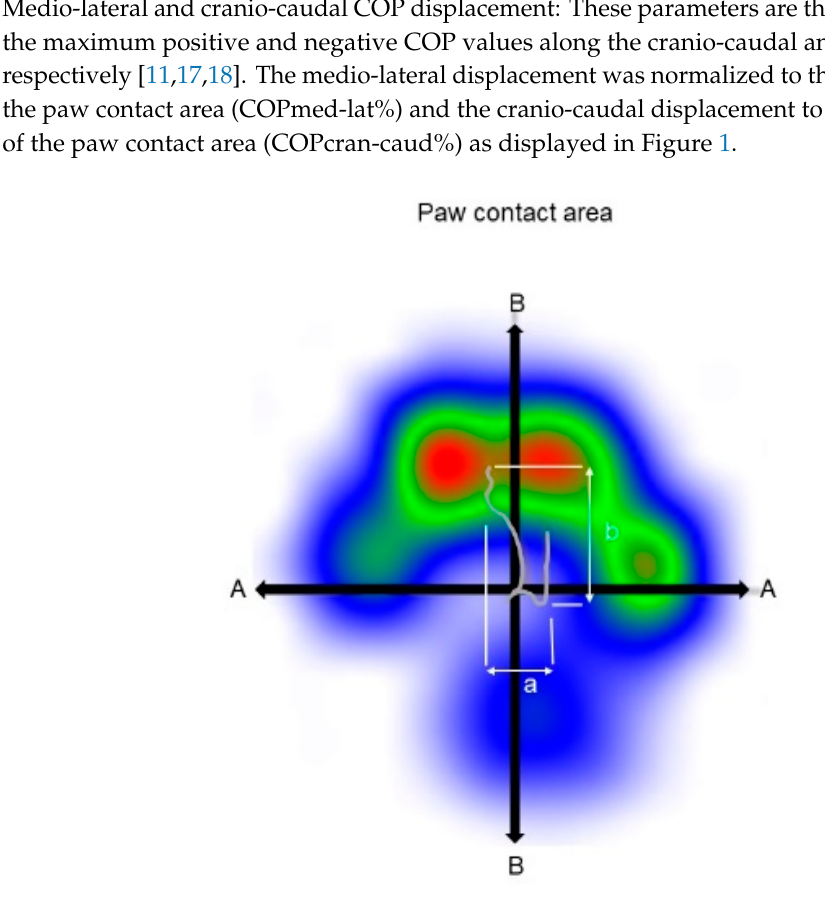
Figure 1. Paw contact area with COP path. The mediolateral ( a ) and craniocaudal ( b ) displacement of the center of pressure were expressed as a percentage of A and B, respectively. a = mediolateral displacement of COP; b = craniocaudal displacement of COP; A = maximum width of paw contact area; B = maximum length of paw contact